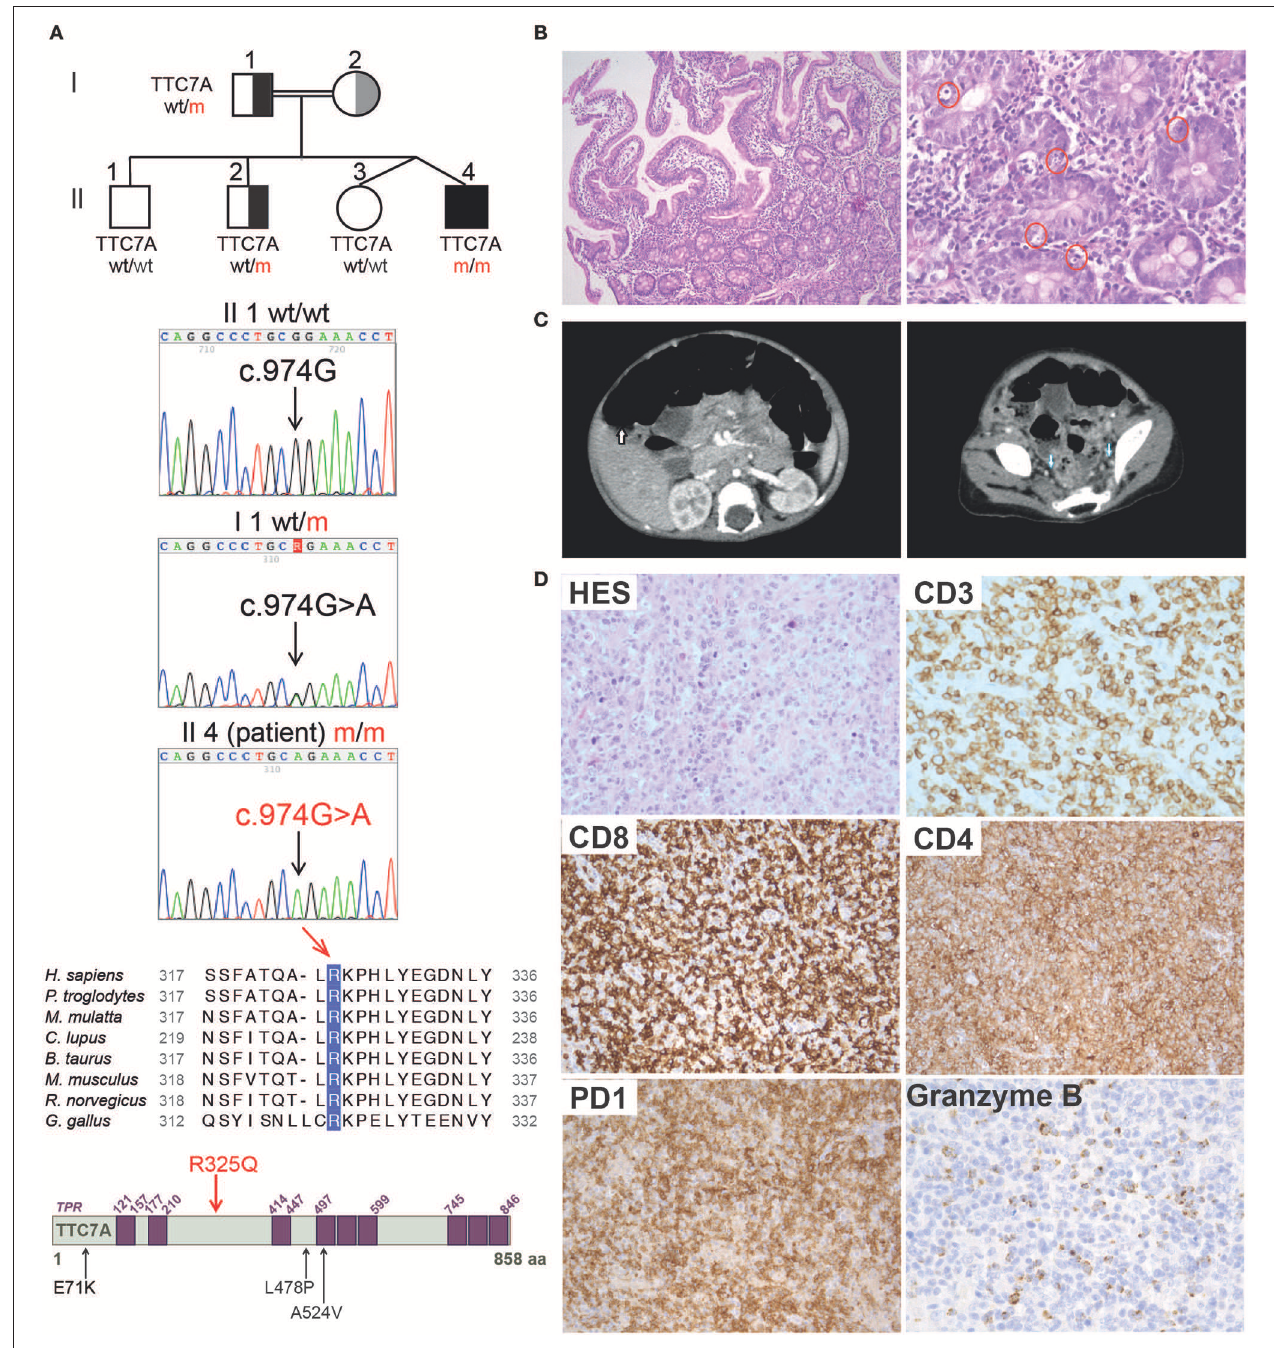
FIGURE 1 | Family pedigree, TTC7A mutation, and histopathological findings in reported patient. (A) From top to bottom: family pedigree; Sanger sequencing chromatogram depicting the c.974G > A mutation in TTC7A gene; alignment of the amino acid (aa) surrounding the conserved R325 residue in TTC7A homologs from 8 species; illustration of TTC7A protein in which purple boxes indicate tetratricopeptide repeats (TPRs) domains, the R325Q homozygous mutation identified in reported patient (Il4 m/m) is highlighted in red, in contrast to mutations previously reported in other TTC7A patients and relevant to this study, which are indicated in black. (B) Histologic analysis of duodenal biopsies from P_R325Q patient (11 months old). Hematoxylin and Eosin (H&E) staining was performed, magnifications of the left and right panels are 100 and 400X, respectively. In the higher magnification panel, red circles denote excess apoptotic epithelial cells in the crypts. (C) Scanners showing hepatosplenomegaly (left, white arrow) and lymphadenopathies (right, blue arrow) performed in P_R325Q patient at the age of 14 months. (D) Histologic analysis of axillary lymph nodes from P_R325Q patient at 6.5 years. H&E staining (HES) (top left, 400X magnification) of a T cell area showed a polymorphic expansion of lymphoid cells admixed with plasma cells, macrophages and eosinophils. CD3 (400X magnification) positive T cells were often medium and large. These T cells were predominantly CD8, with expression of PD1 (200X magnification) and granzyme B (400X magnification). CD4 staining (200X magnification) identified numerous macrophages and a minority of